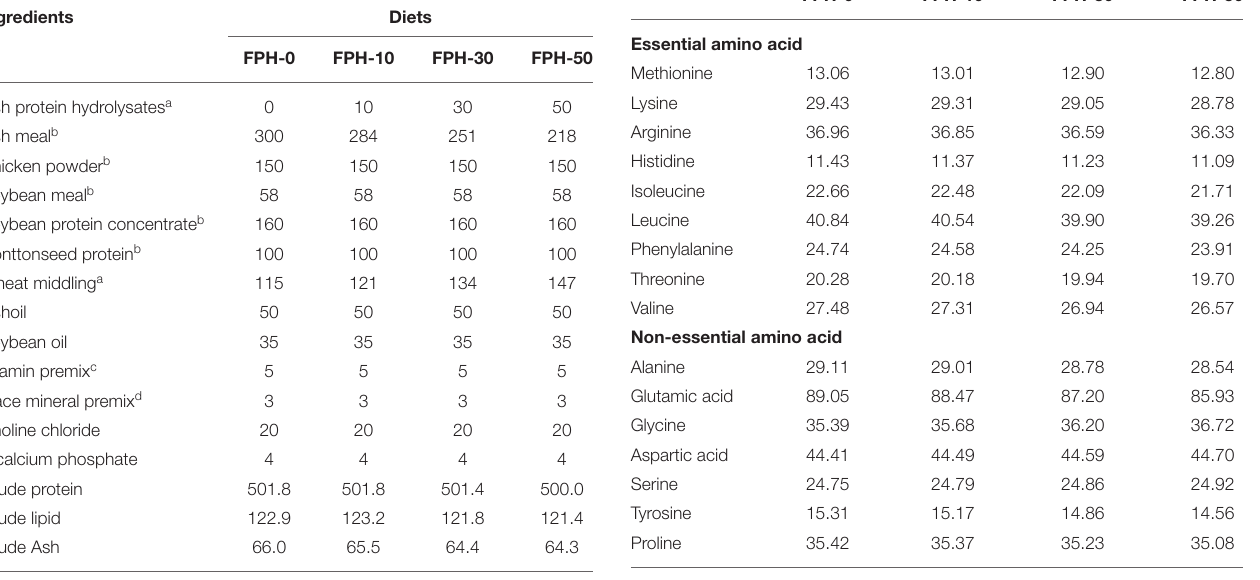
TABLE 1 | Ingredients and proximate composition of the experimental diets (g/kg of dry matter basis). Ingredients